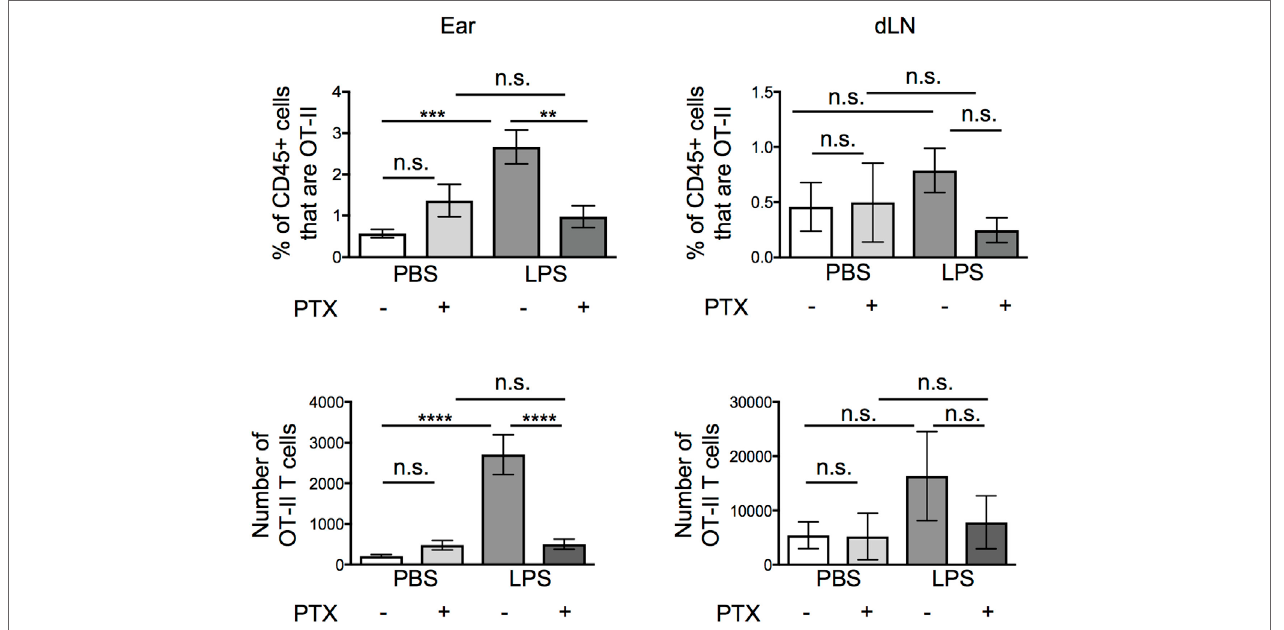
FigUre 4 | Signals through G protein-coupled receptors cause increased persistence of activated CD4 T cells at lipopolysaccharide (LPS)-inflamed sites. Activated OT-II T cells were treated with vehicle or pertussis toxin (PTX) before transfer into the ear pinnae of mice injected with PBS or LPS, 24 h earlier. After a further 24 h, the percentages and numbers of transferred OT-II T cells in the homogenized ear or draining lymph node were examined by flow cytometry. Data are combined from two to three independent experiments with ≥ 3 animals per group. In this figure, p < 0.01 is indicated by **; p < 0.001 is indicated by ***; and p < 0.0001 by ****; n.s.,